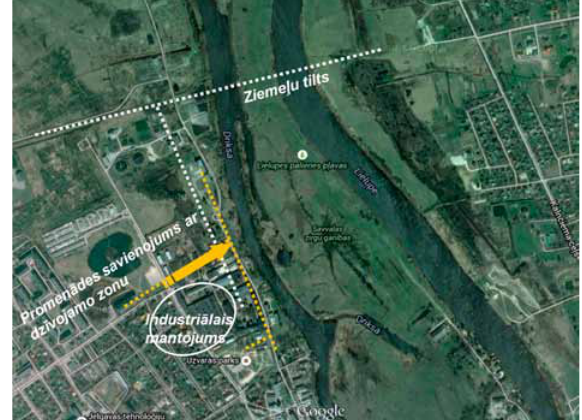
fig. 8. The canvas of the historical sites of manors is readable in the contemporary urban structure Source: author ᾽ s scheme,